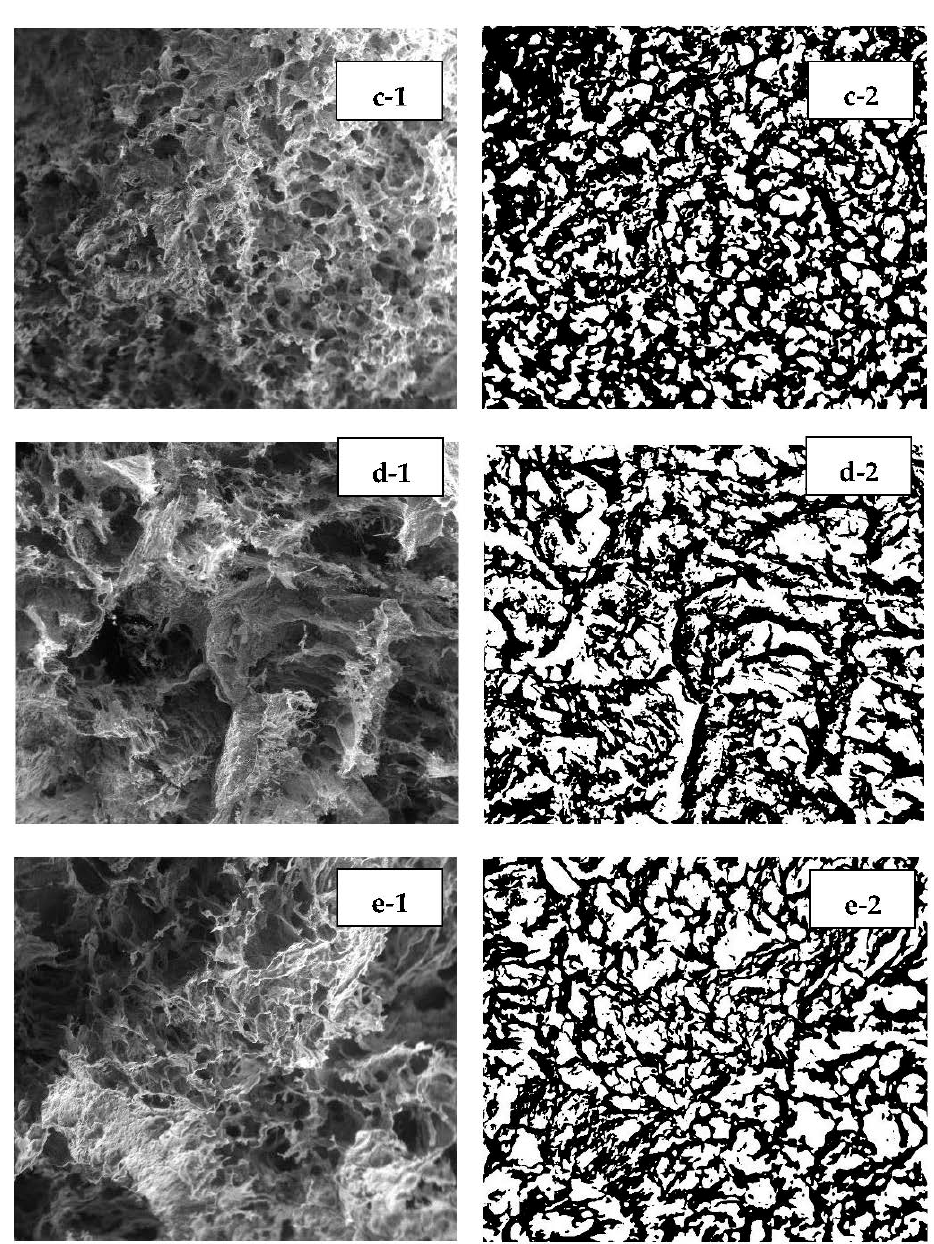
Figure 7. Morphological pattern of hydrogel Alginate/PVA/r-GO after degradation test for 28 days with the addition of 0 wt.% r-GO ( a-1 , a-2 ), 0.4 wt.% r-GO ( b-1 , b-2 ), 0.8 wt.% r-GO ( c-1 , c-2 ), 1.2 wt.% r-GO ( d-1 , d-2 ), and 1.6 wt.% r-GO with 100 × magnifications ( e-1 , e-2 ); ( 2 ) indicate the results of pore identification using ImageJ software with the same composition. (1) refers to the original SEM picture (2) represent image J result. Table 3. The comparison means pore size of hydrogel Alginate/PVA/r-GO before and after 28 days of immersion.